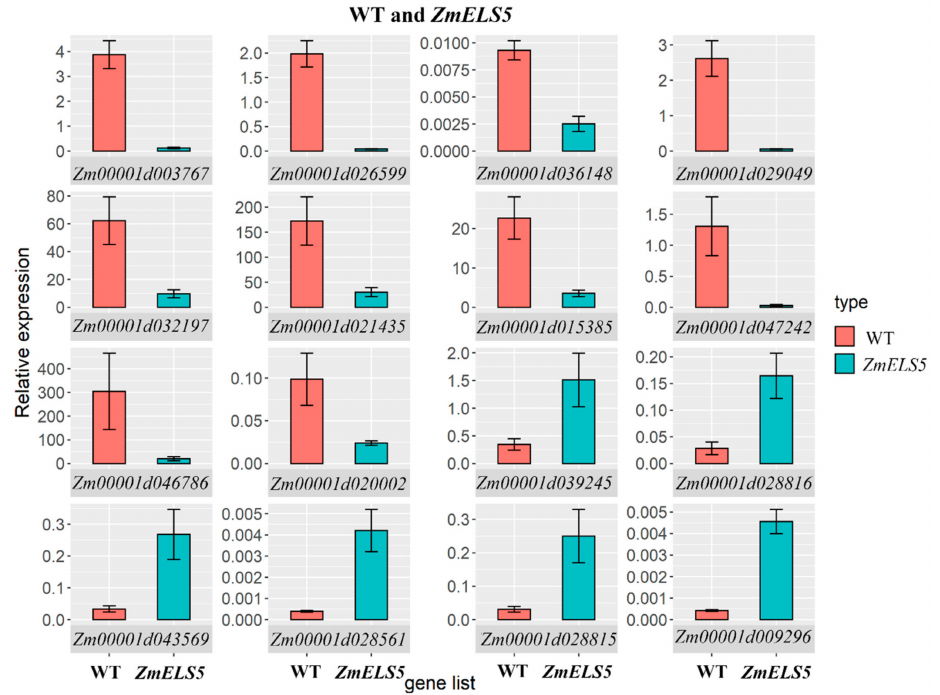
Figure 9. Comparison of expression of WT and ZmELS5